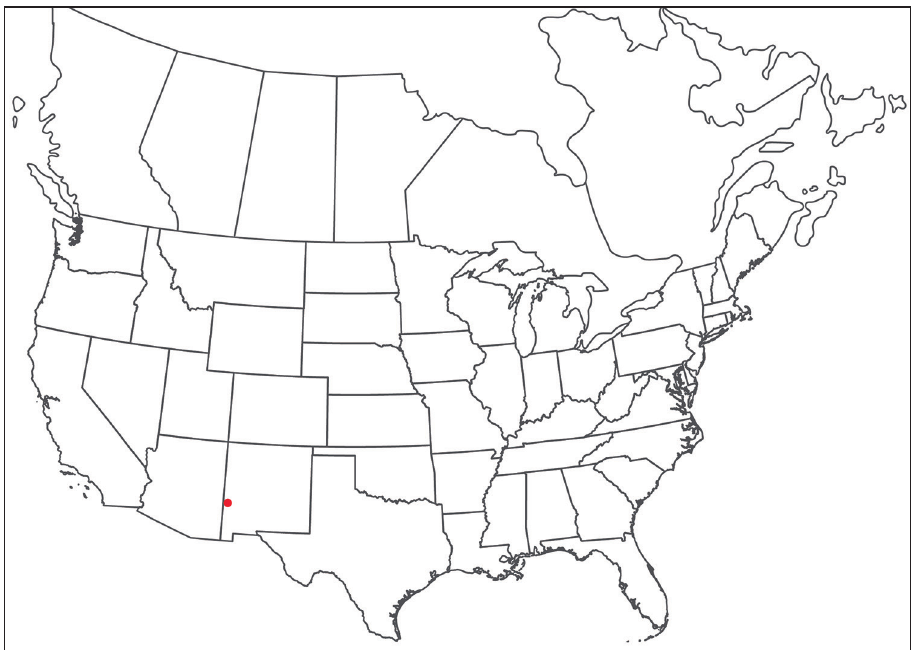
Figure 19. Torrenticola anoplopalpa sp. n.